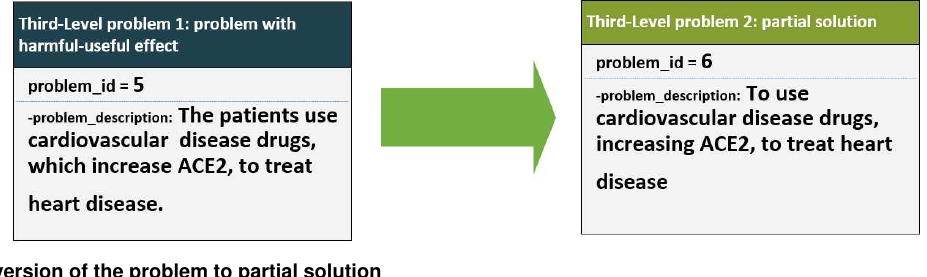
Figure 8. Conversion of the problem to partial solution